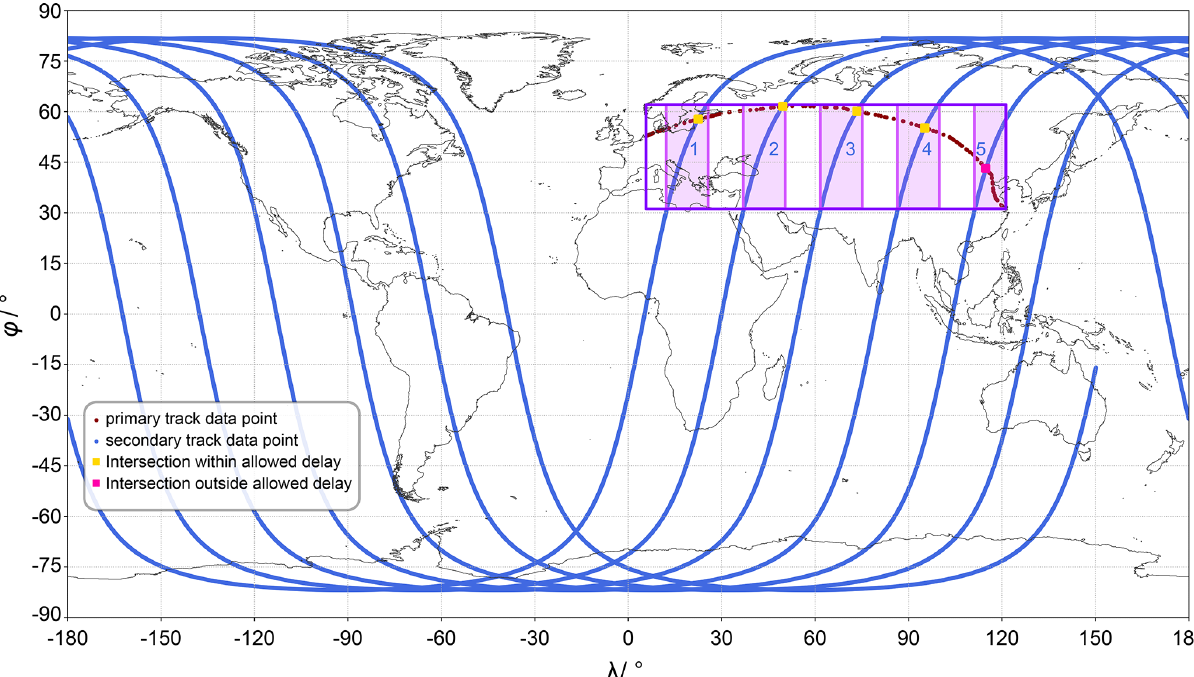
Figure 2. Example plot of flight (primary) and satellite (secondary) track data and the intersections found by the algorithm.